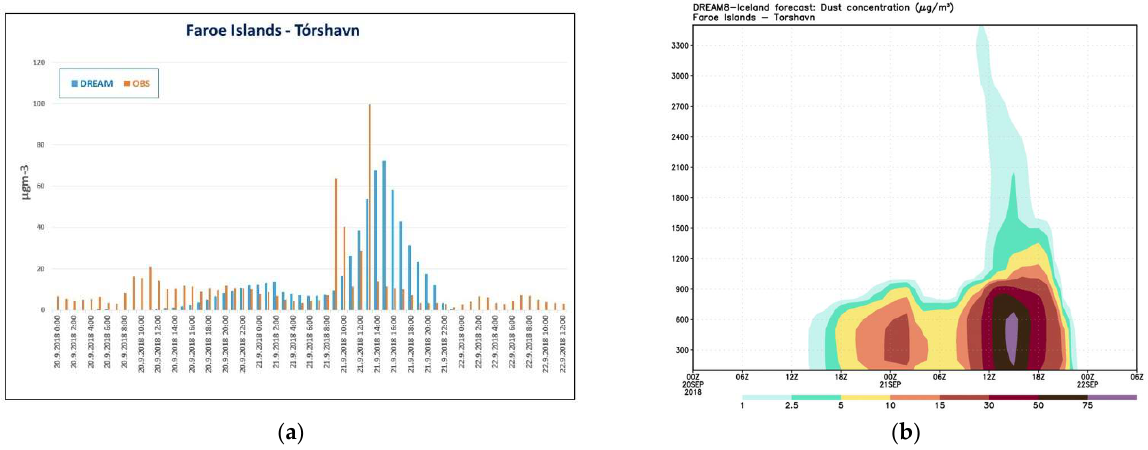
Figure 15. Faroe Islands (Torshavn)—Dust episode 21–22 September 2018: ( a ) Observed (orange) and predicted (blue) PM 10 concentrations (µgm −3 ); and ( b ) time–height plot of dust concentration (µgm −3 ).